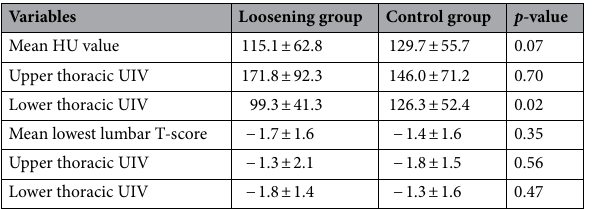
Table 2. Comparison of HU values and T-scores according to UIV level. HU Hounsfield unit, UIV upper instrumented